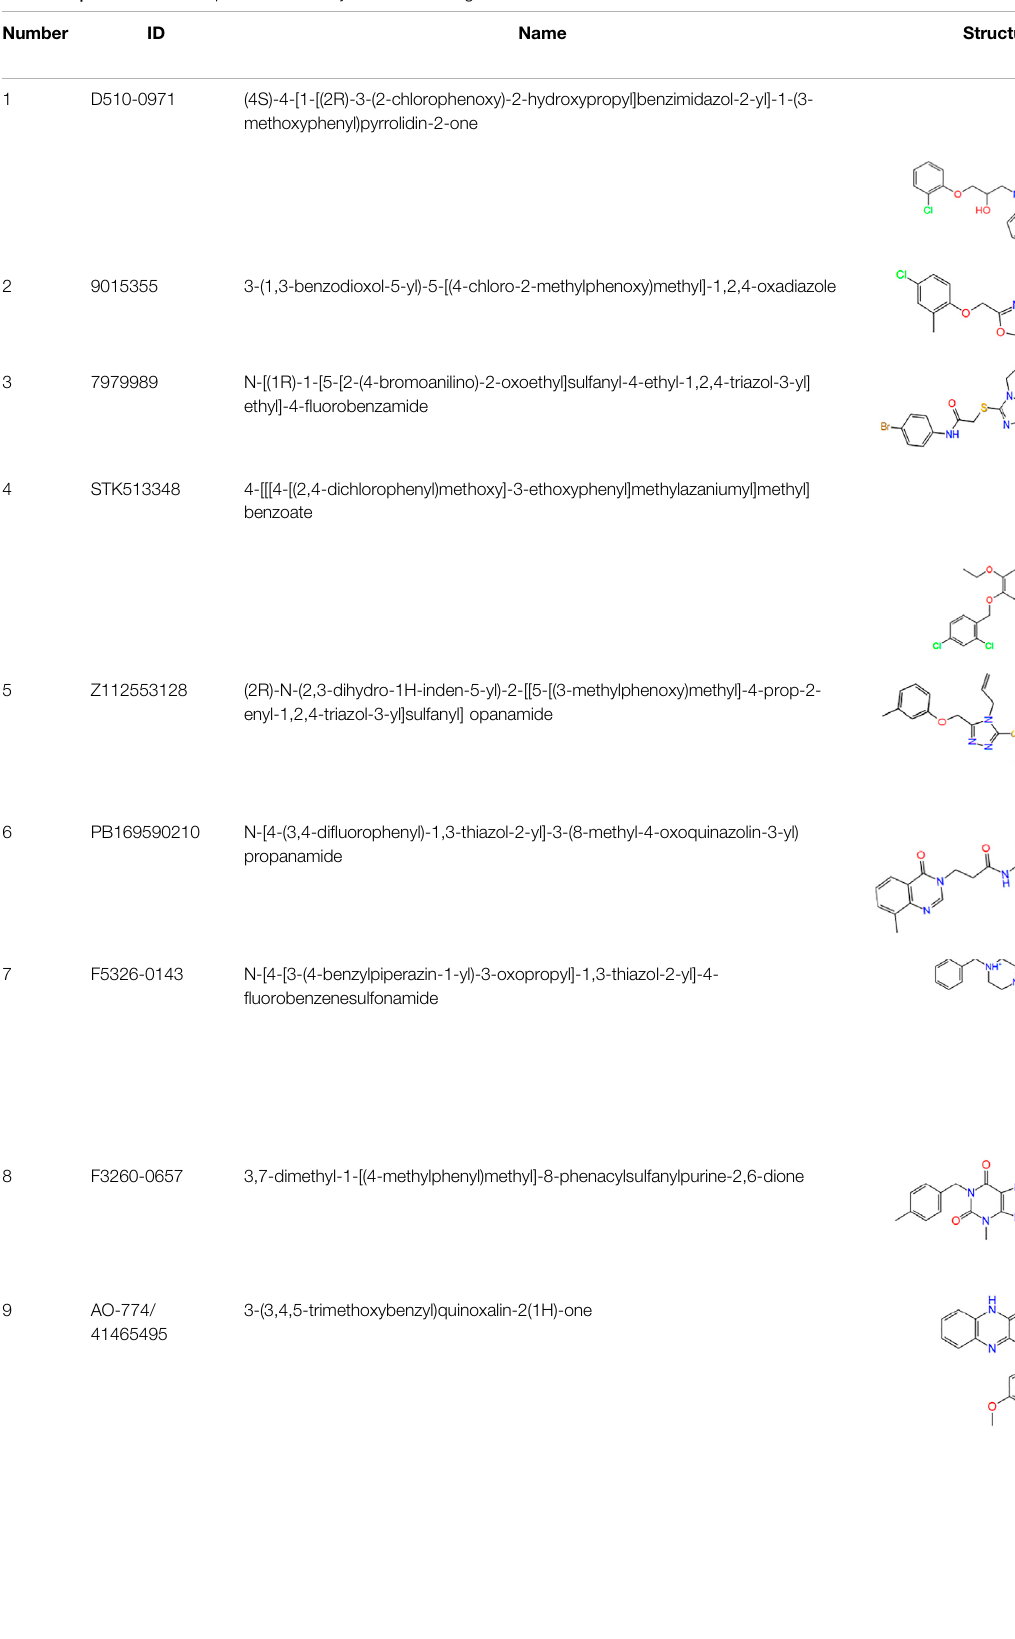
TABLE 1 | Potential hit compounds obtain by virtual